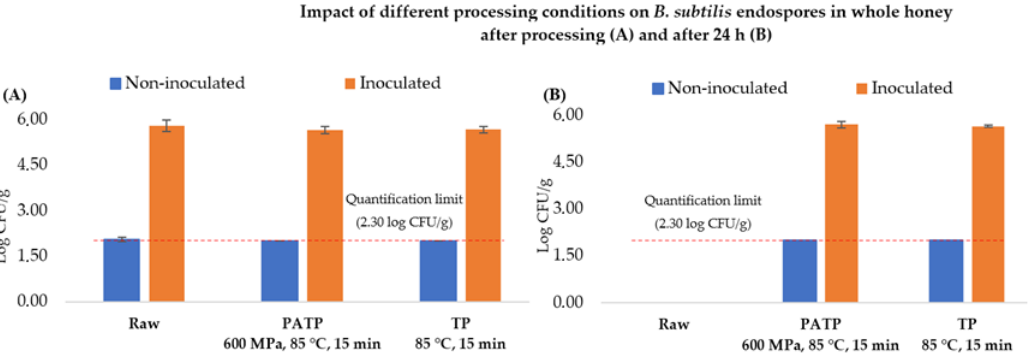
Figure 2. Effects of pressure-assisted thermal pasteurization (PATP) and conventional thermal pas- teurization (TP) on the survival of total B. subtilis microbial load (TML) in non-inoculated honey (blue bars) and the total B. subtills endospore load (TEL) in inoculated honey (orange bars): ( A ) im- mediately after processing (day 0), and ( B ) after 24 h of storage of the processed honey. Dashed bars mean that the quantification limit of 2.30 log CFU/g was reached.